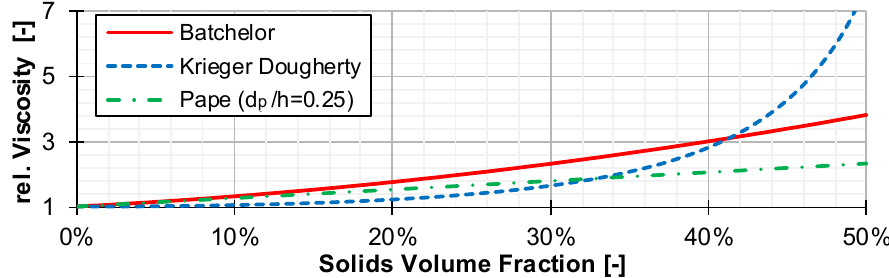
Figure 9. Comparison of the relative viscosities of different models over the solids contents.